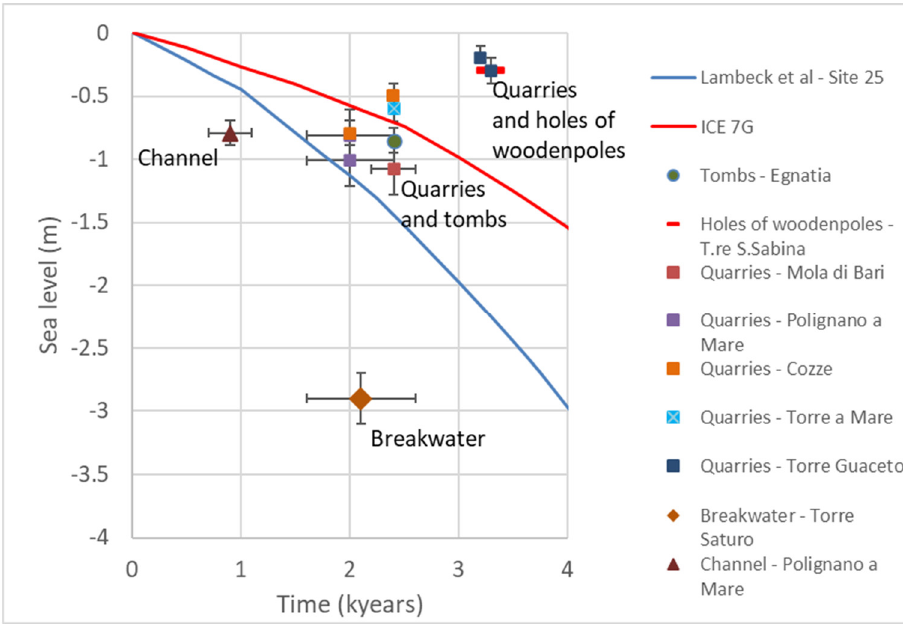
Figure 8. Comparison of sea level data from the current elevations based on geoarchaeological evidence along the coast compared with the Lambeck curve [2] and ICE-7G [3,5].